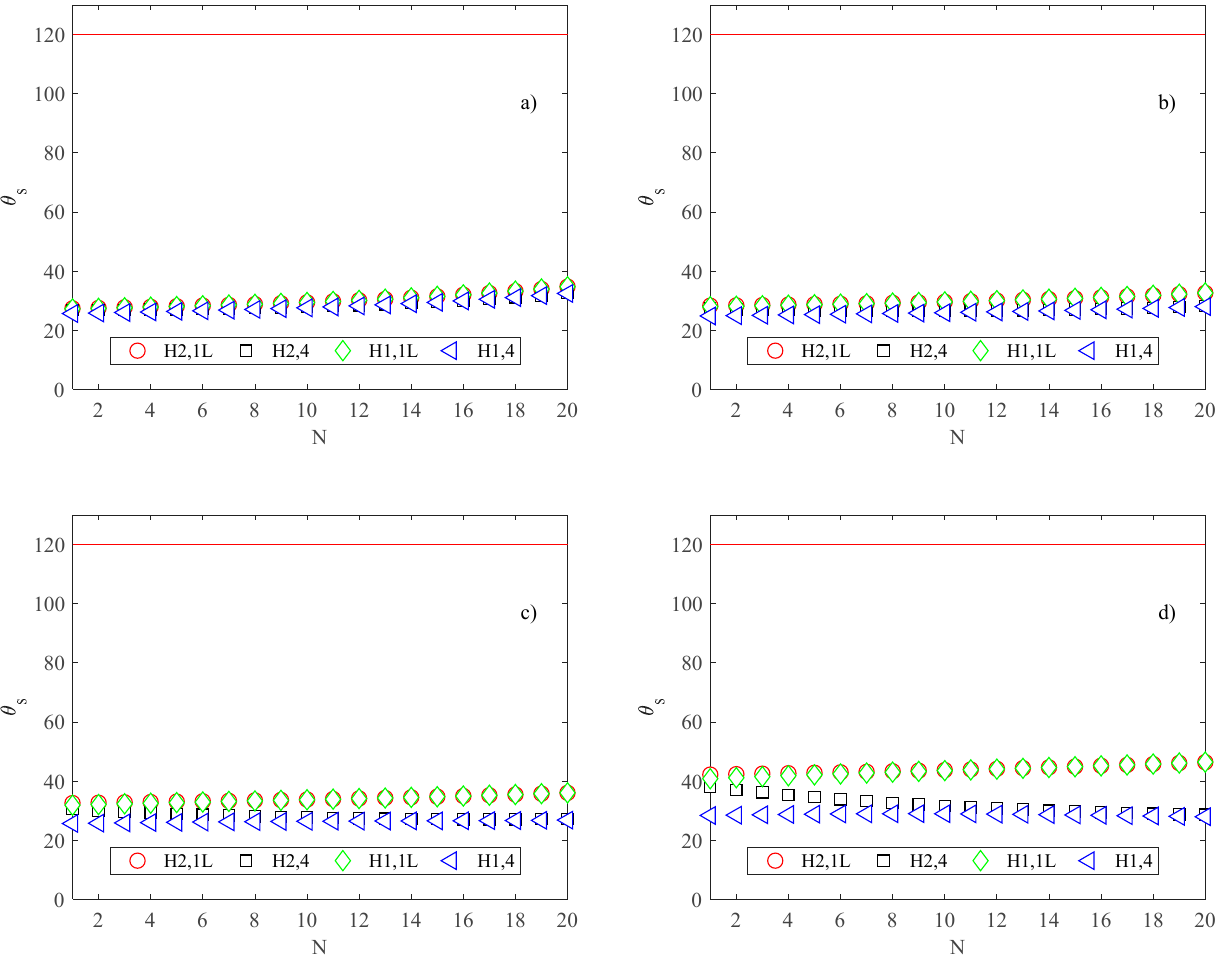
Figure 9. Maximum substrate temperature (°C); ( a ) B = L = 2.5 mm; ( b ) B = L = 5 mm; ( c ) B = L = 10 mm; ( d ) B = L = 20 mm.